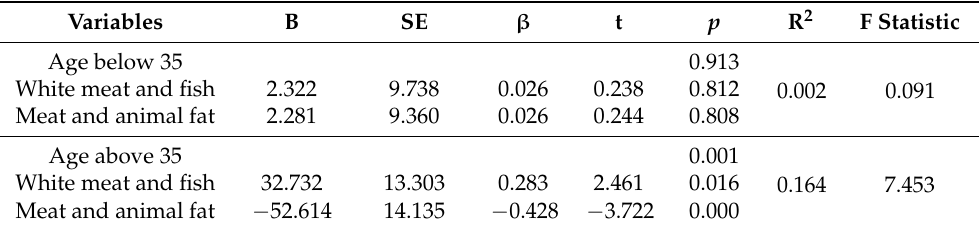
Table 8. Explanations of the interaction effects (age × white meat and fish and age × meat and animal fat) showing a simple effect for younger and older age groups on SynWin memory search score predicted by the frequency of white meat and fish consumption and meat and animal fat frequency